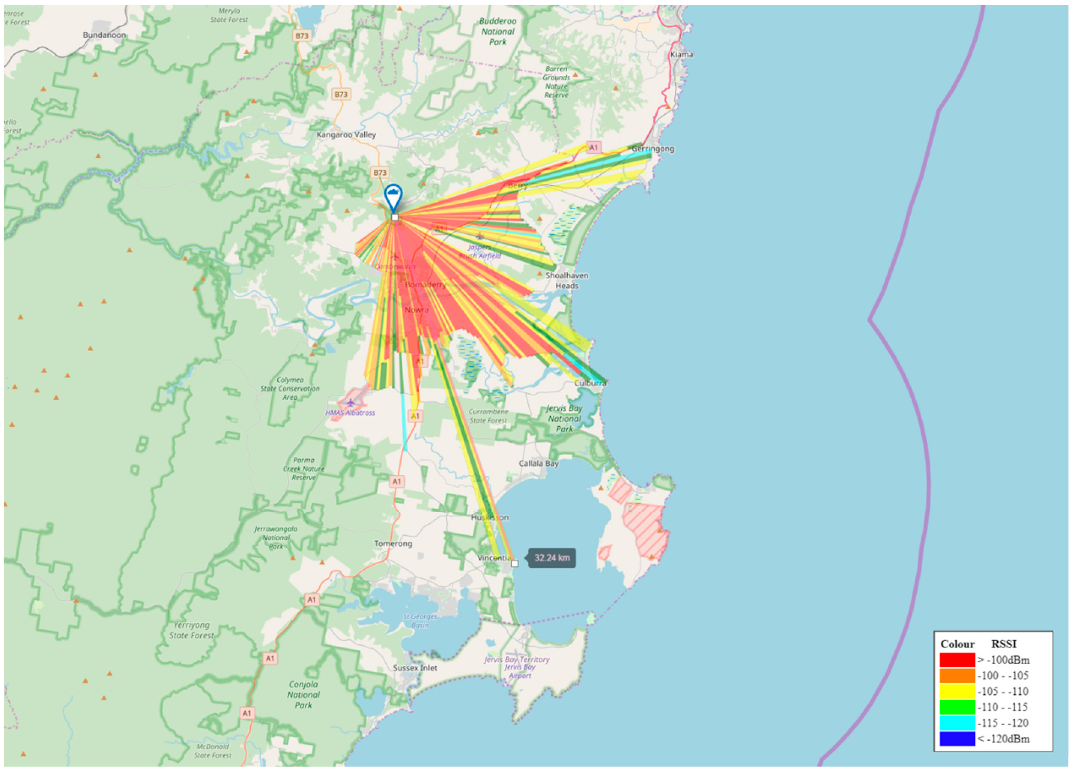
Figure 20. Shoalhaven region radio channel ranging survey. Sensors 2019 , 19 FOR PEER REVIEW